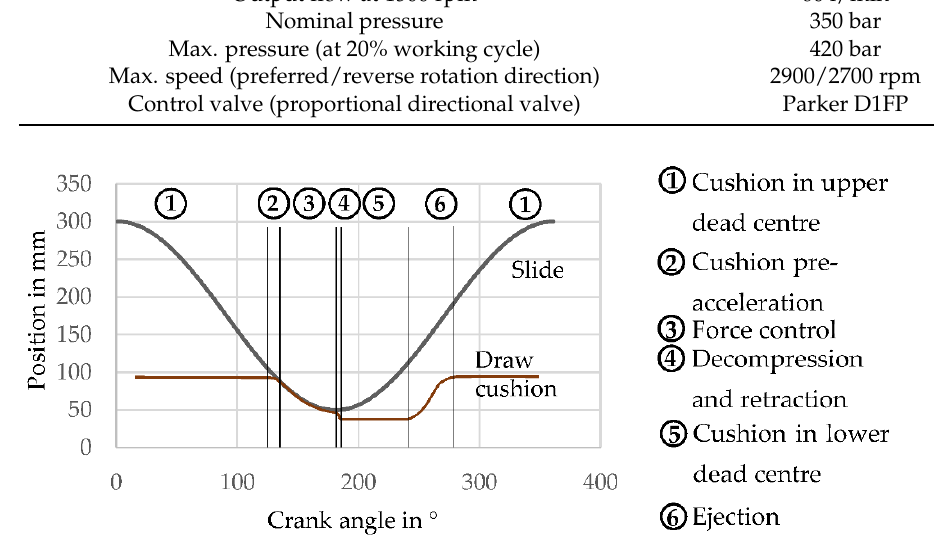
Figure 3. Scheme and sequence of the drawing process according to [12].